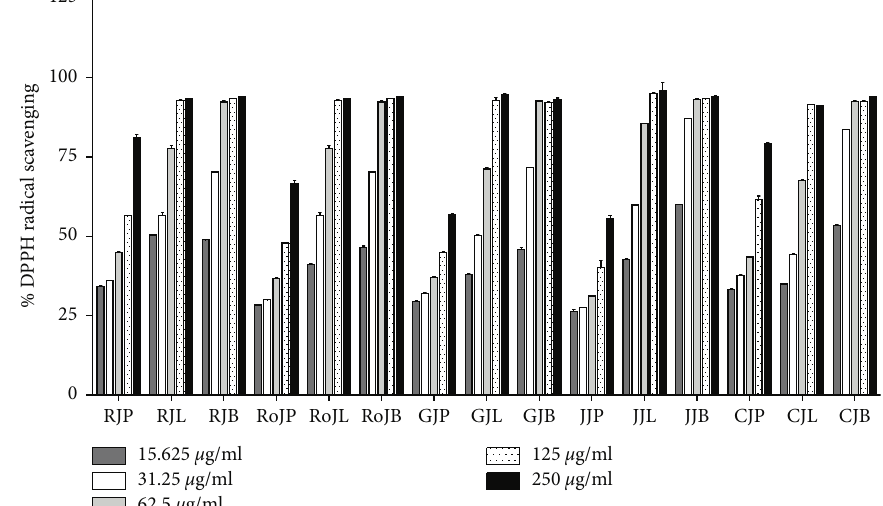
Figure 4: Bar diagram showing DPPH free radical scavenging capacities of peel, leaf, and stem bark extract of five different M. domestica cultivars from Jumla.